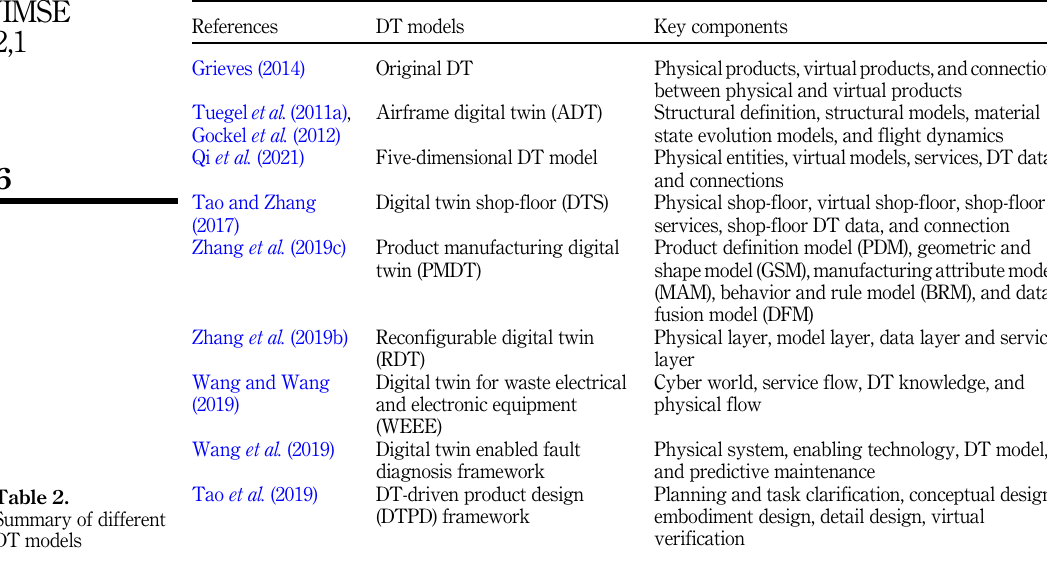
Table 2. Summary of different DT